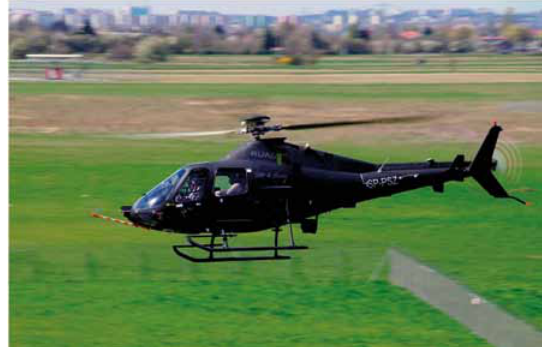
Fig. 2. Unmanned/optionally piloted helicopter “SW-4